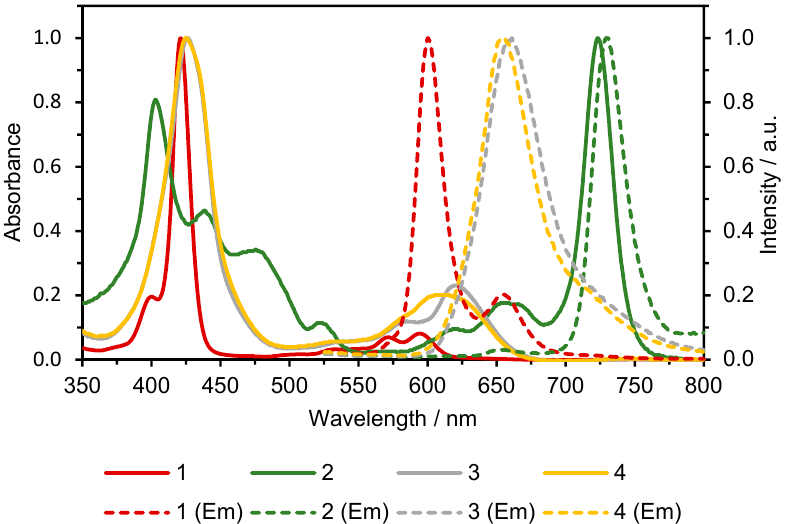
Figure 1. Normalized UV-Vis absorption (solid line) and fluorescence (dashed line) spectra in DMF of corrole 1 and corrole dimers 2 – 4 ( λ exc = 420 nm) at 298 K.